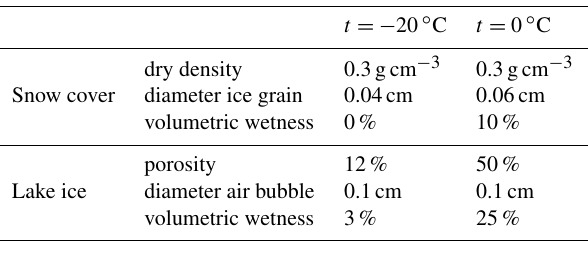
Table 2. Properties of snow cover and lake ice taken for penetration depth calculations. Standard deviations of ice grain and air bubble sizes were assumed at 40%.